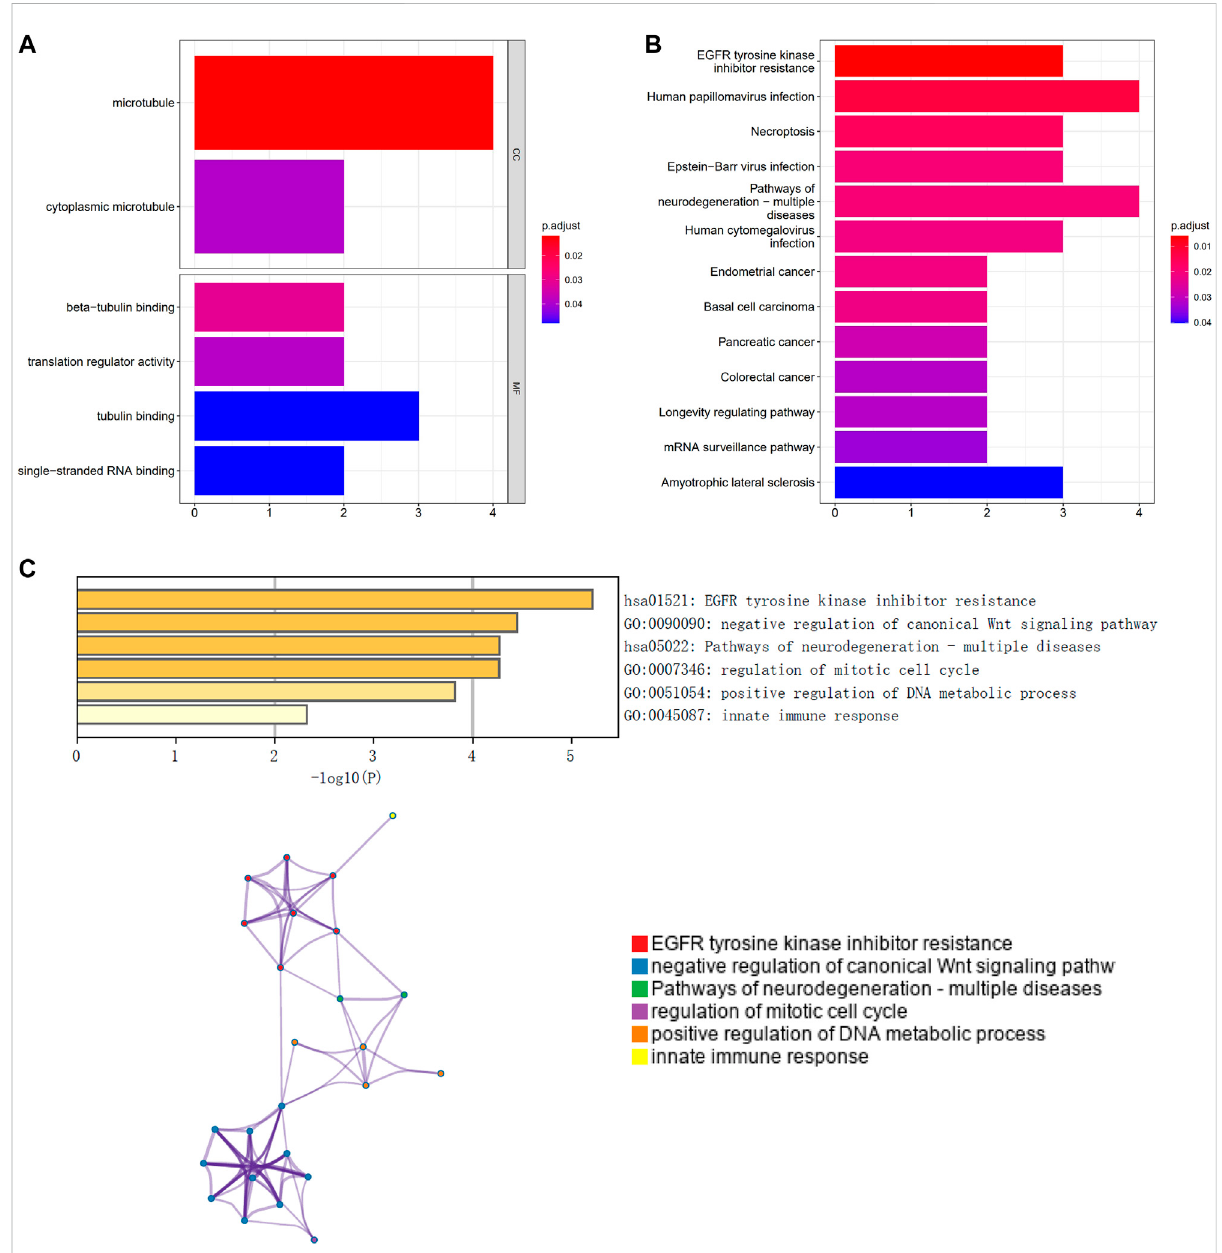
FIGURE 1 Functional enrichment of prognosis-related genes and construction of protein interaction networks. (A) GO analysis; (B) KEGG pathway analysis; (C) Metascape functional